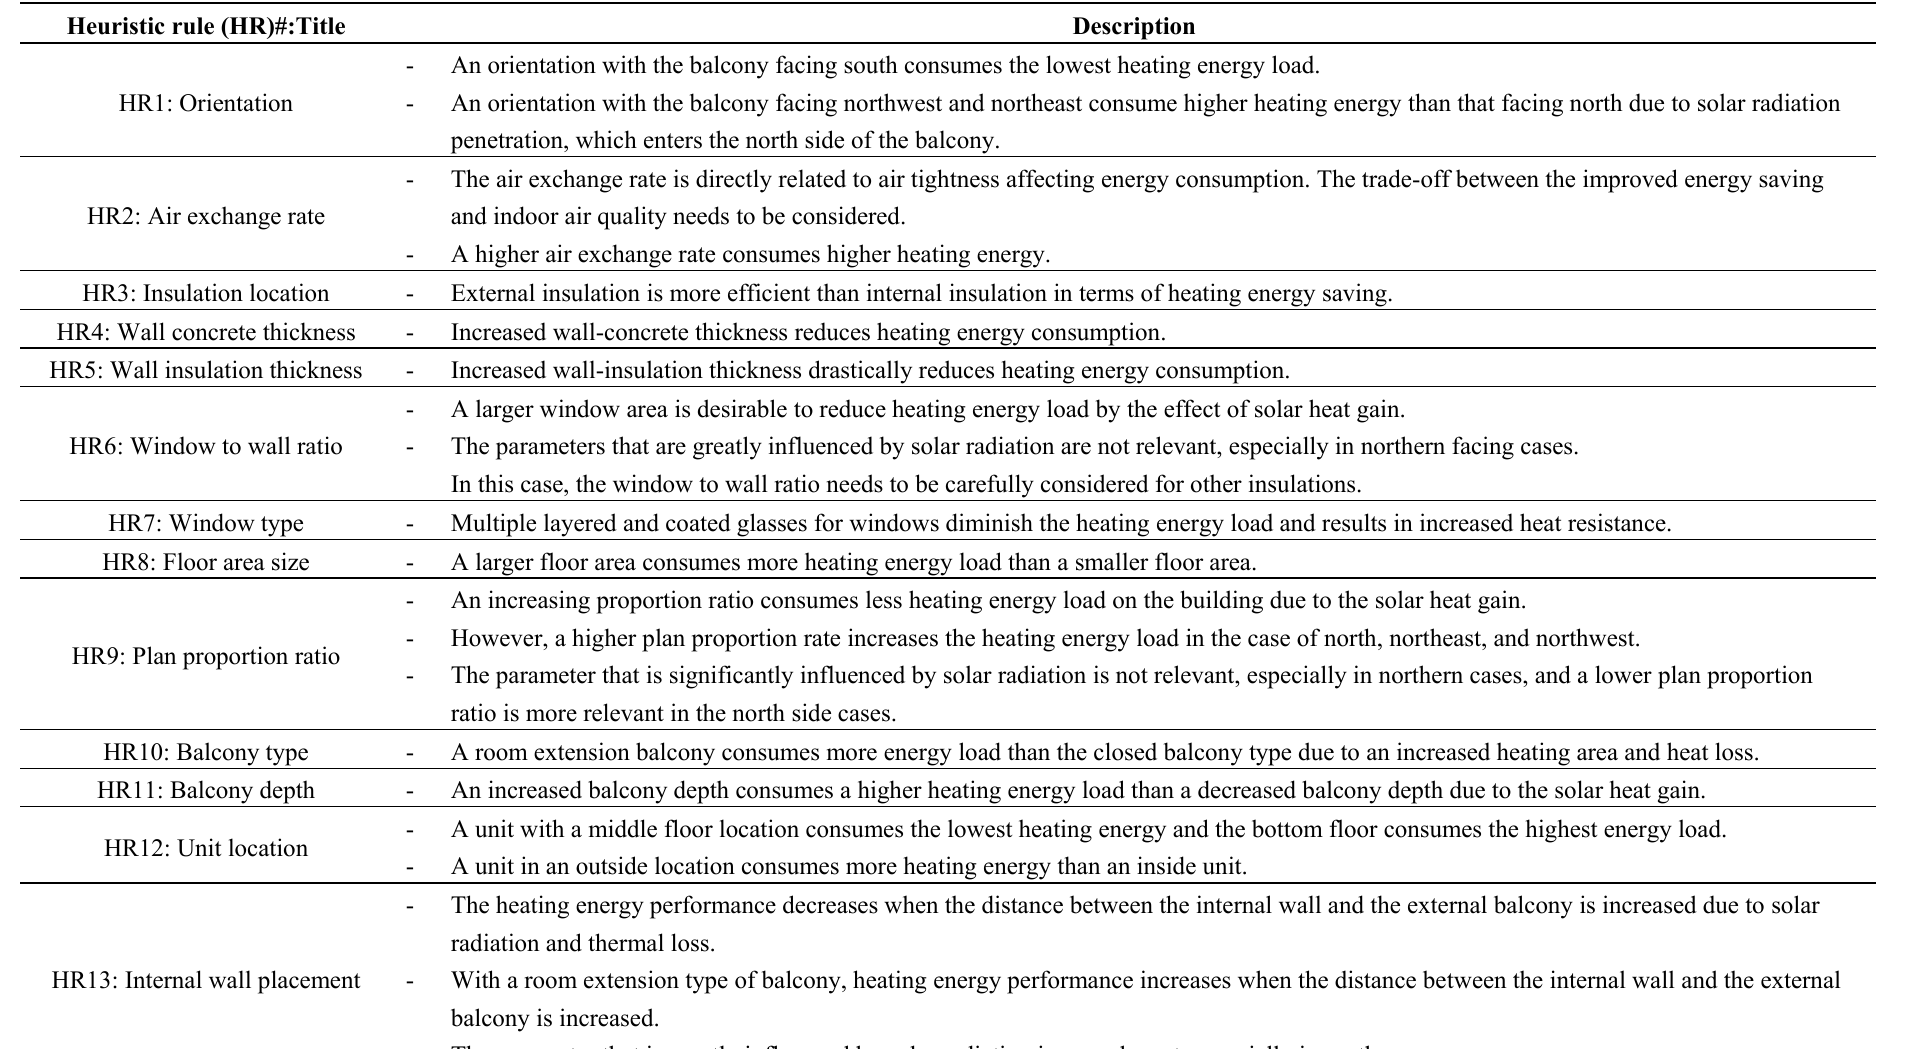
Table 11. Heuristic Rule for minimizing heating energy